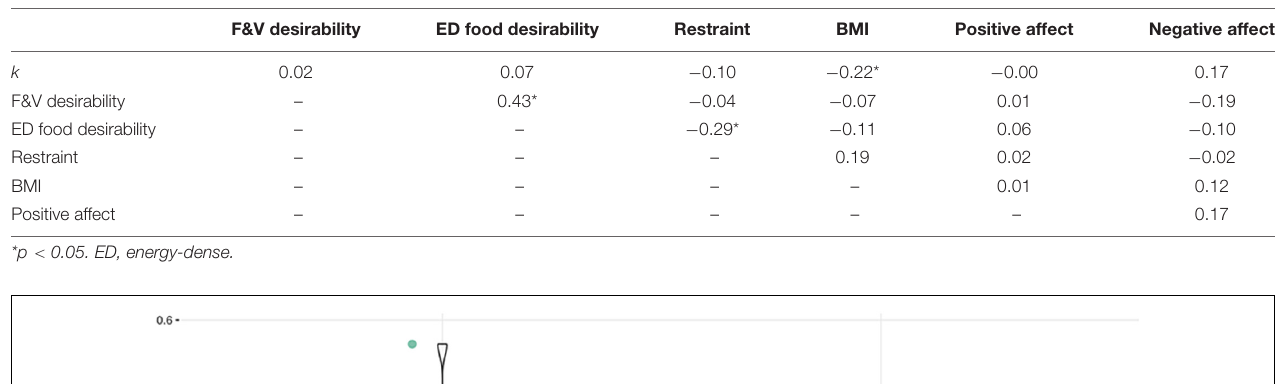
TABLE 3 | Pearson’s correlation coefficients between main variables of interest.